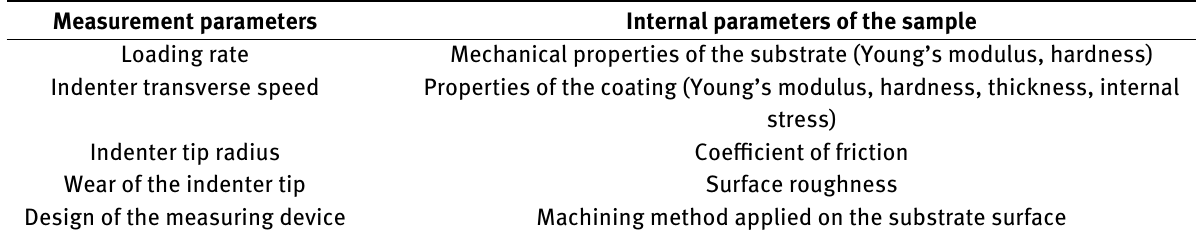
Table 1: Critical scratch test experimental variables (based on [55, 56, 58, 60–62]).